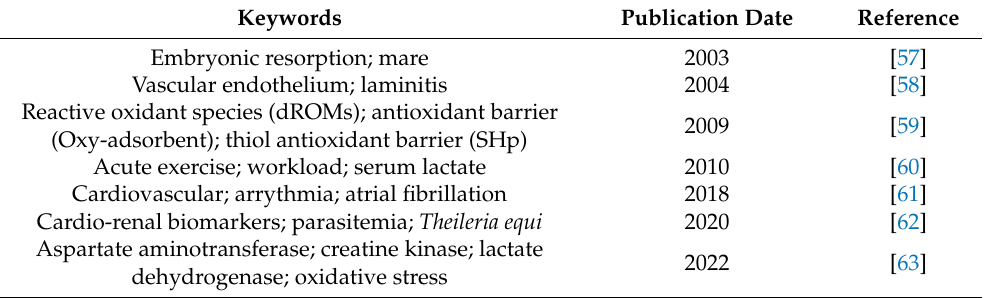
Table 1. Summary of studies (chronologically) on the role of Hcy in the disease pathogenesis in